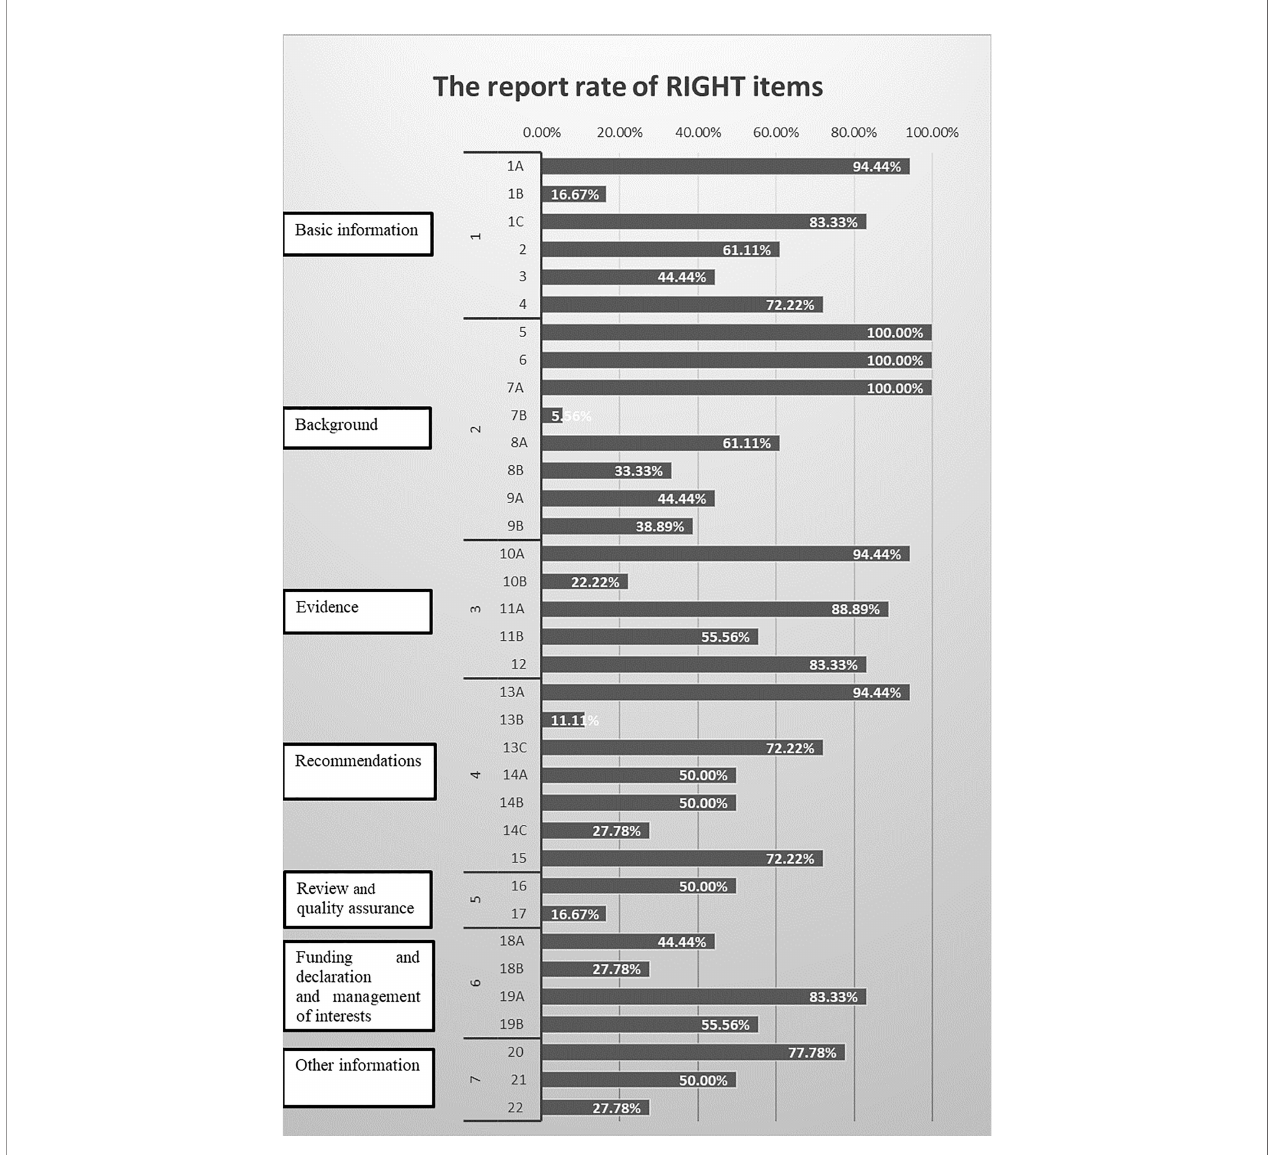
FIGURE 3 | Reporting of RIGHT items in cancer pain